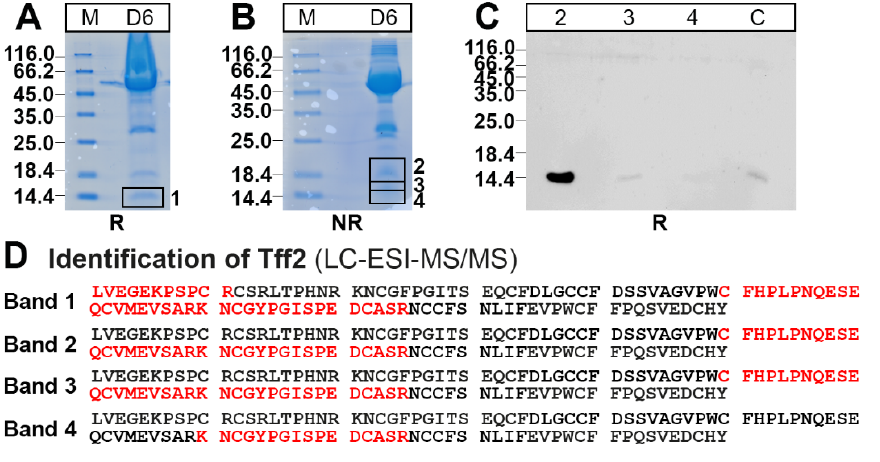
Figure 4. Proteome analysis of the low-molecular-mass form of Tff2 in a pancreatic extract (fraction D6 from Figure 3). ( A ) SDS-PAGE under reducing (R) conditions and Coomassie staining. Band 1 was excised. ( B ) NR SDS-PAGE and Coomassie staining. Bands 2, 3, and 4 were excised, proteins eluted, and subjected to reducing SDS-PAGE. ( C ) Western blot analysis concerning Tff2 (bands 2–4; C positive control). ( D ) Results of the proteome analyses after tryptic in-gel digestion of bands 1–4. Identified regions in Tff2 are shown in red.